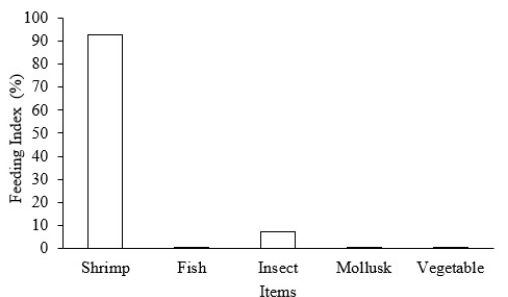
Figure 2. Feeding Index (%) of the Plagioscion squamosissimus , collected quarterly, between February 2011 and November 2014, at the Santa Cruz Reservoir, Rio Grande do Norte,